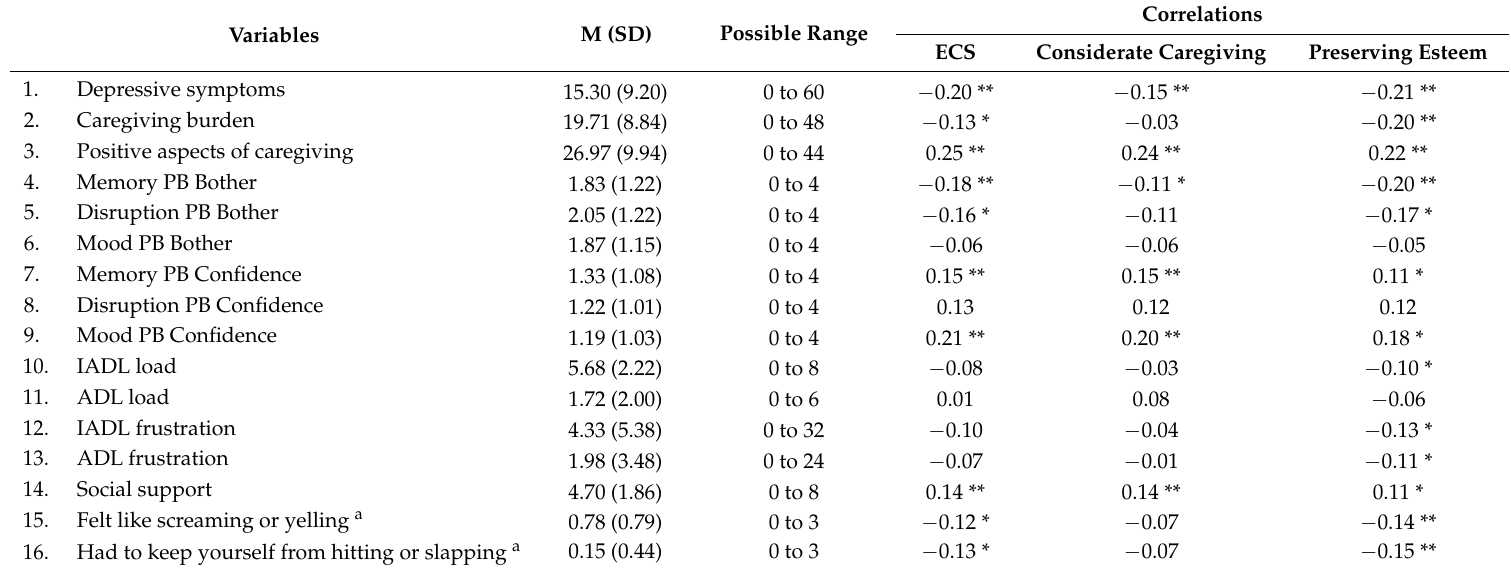
Table 4. Correlations of ECS and its subscales with caregiver